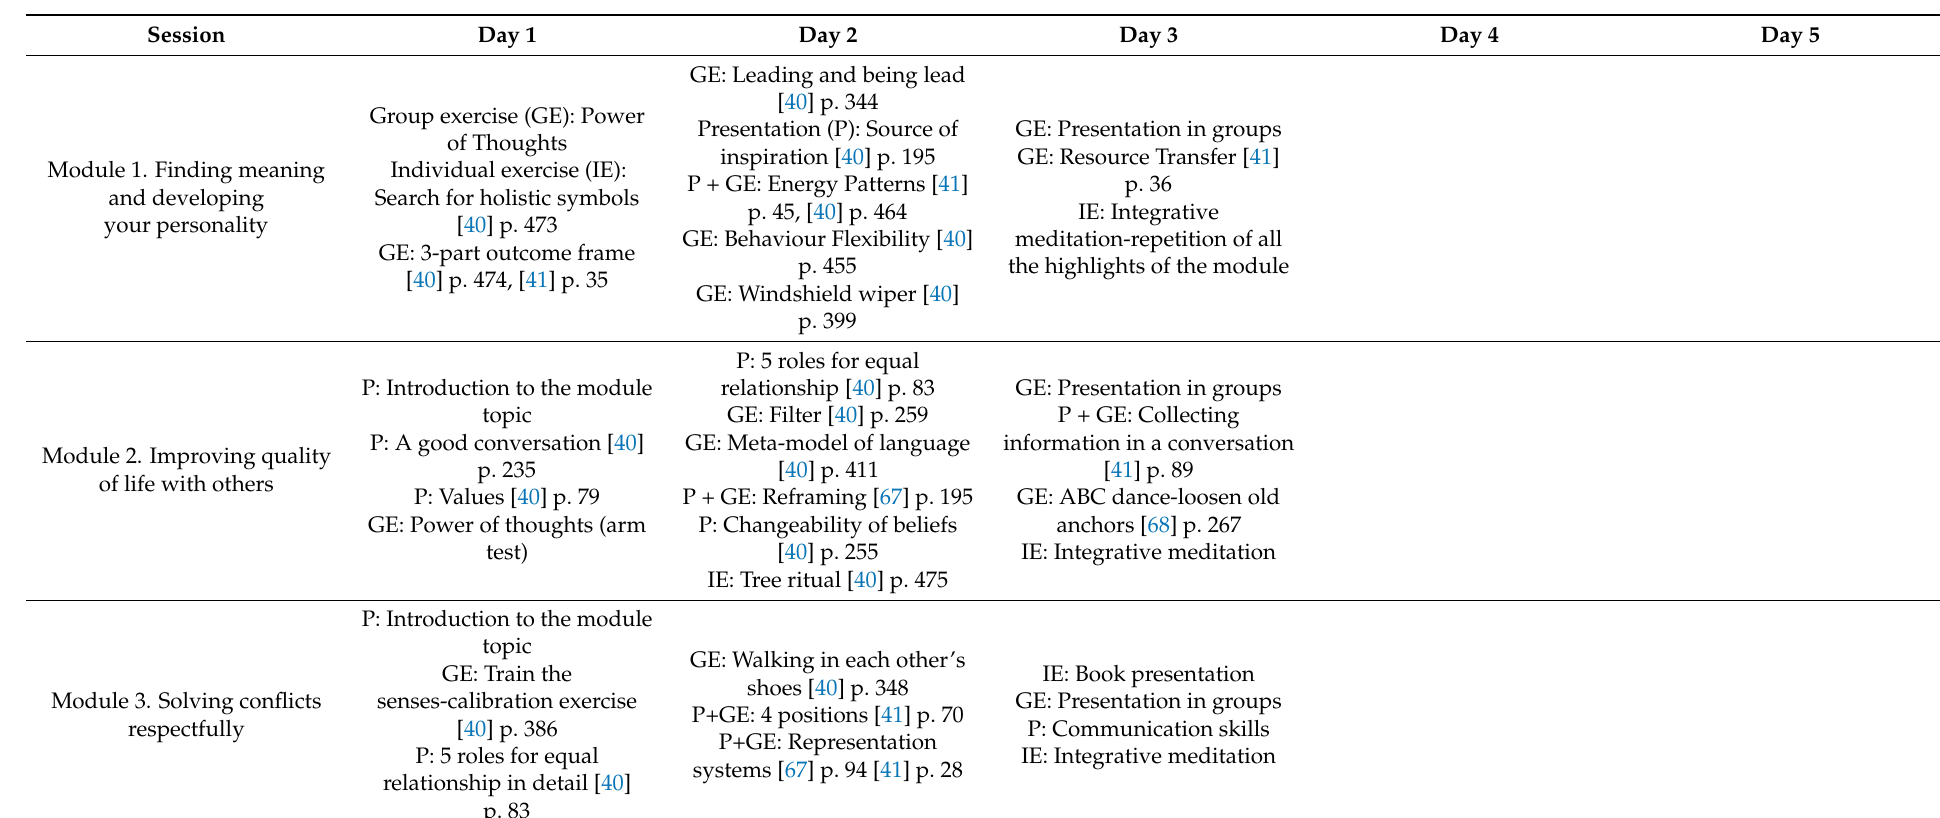
Table A1. Session-by-Session Outline of the Kutschera Resonanz ® Practitioner Intervention Programme with “Group Exercises” (GE), “Individual Exercises” (IE), and “Presentations” (P) and their